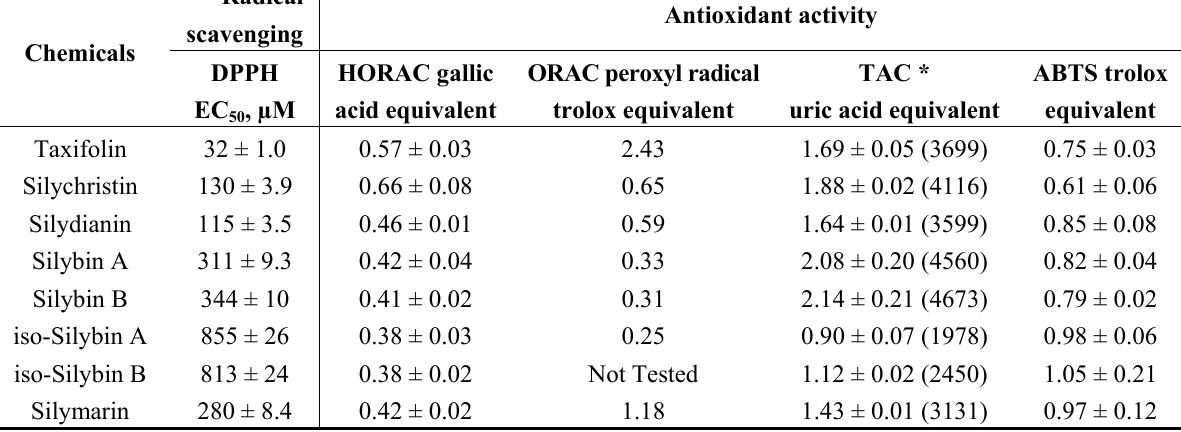
Table 1. Radical scavenging and antioxidant activities of silymarin and its individual components.